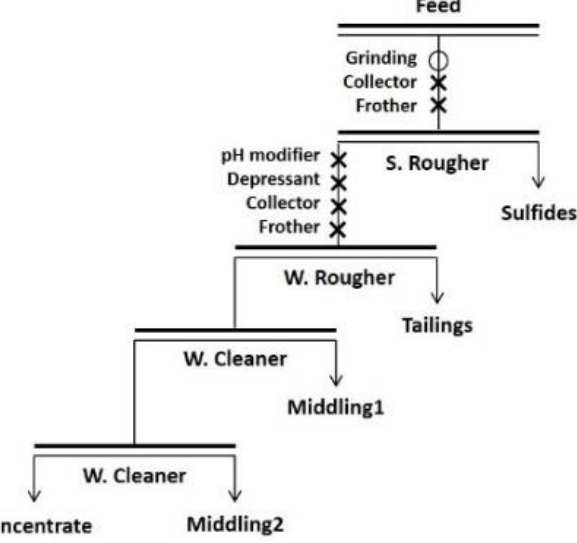
Figure 1. Flowsheet of the batch type scheelite flotation from tungsten ore .